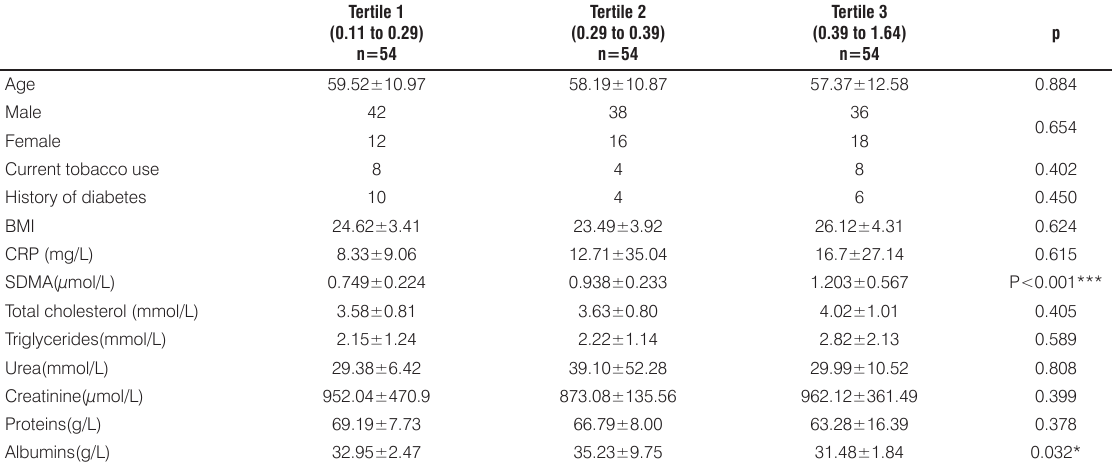
Table 2. Baseline characteristics of the patients by tertiles of ADMA